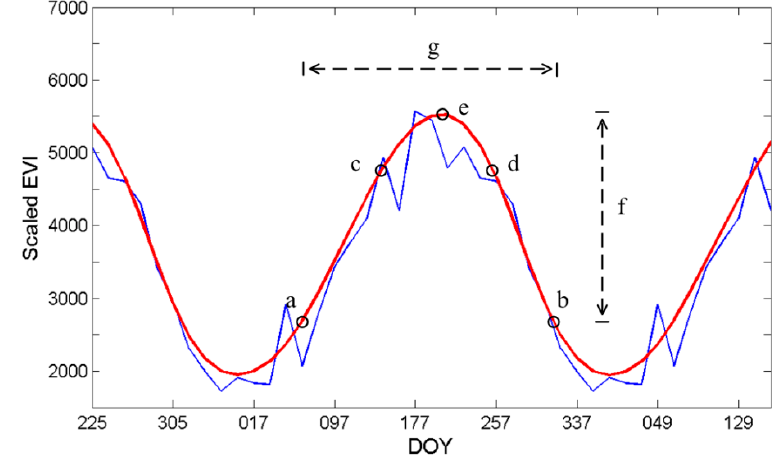
Figure 3. Points ( a , b ) mark, respectively, start and end of the season. Points ( c , d ) give the 80% levels. ( e ) displays the point with the largest value. ( f ) displays the seasonal amplitude and ( g ) the seasonal length. The blue line indicates the time-series EVI data and read line indicates the fitting curve of the original data.